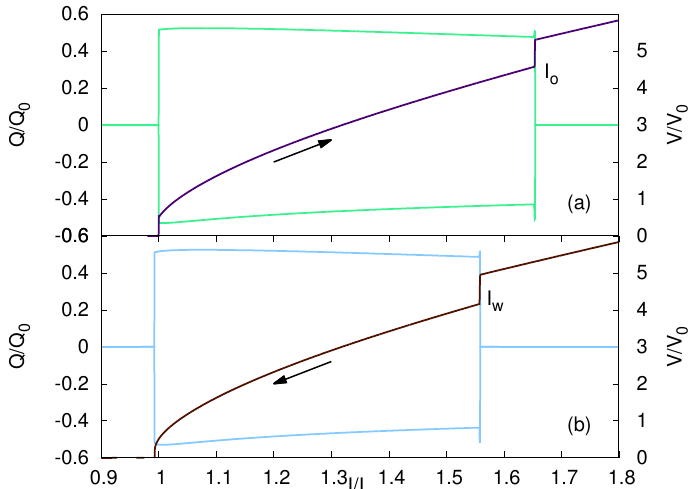
Figure 2. Dependences on current of voltage (dark color lines), together with minimal and maximal values of charge (light color lines), are shown for the increase ( a ) and for the decrease ( b ) of current. The direction of current is shown with arrows. Labels for outermost switching and the wave switching currents are shown next to the corresponding current